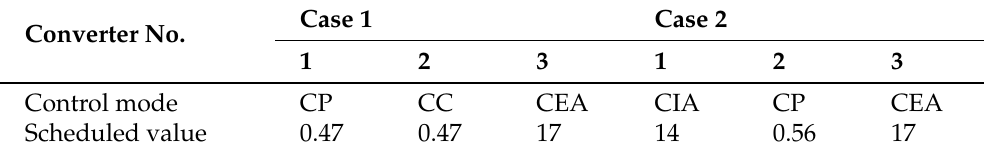
Table 10. Control modes configuration for Cases 1 and